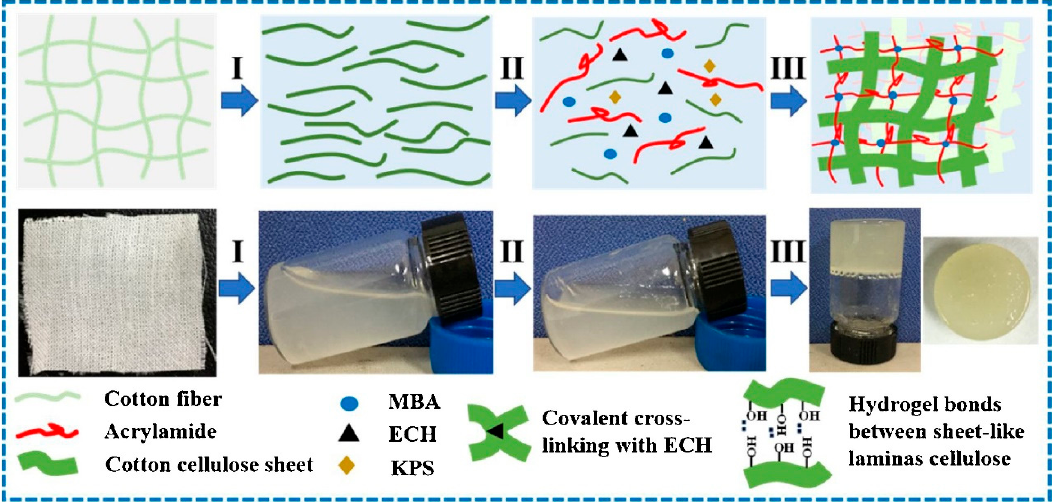
Figure 10. Synthesis of cellulose-based hydrogel: I—hydrolysis in NaOH, II—crosslinking, III—ge- lation process, reprinted with permission from Ref.